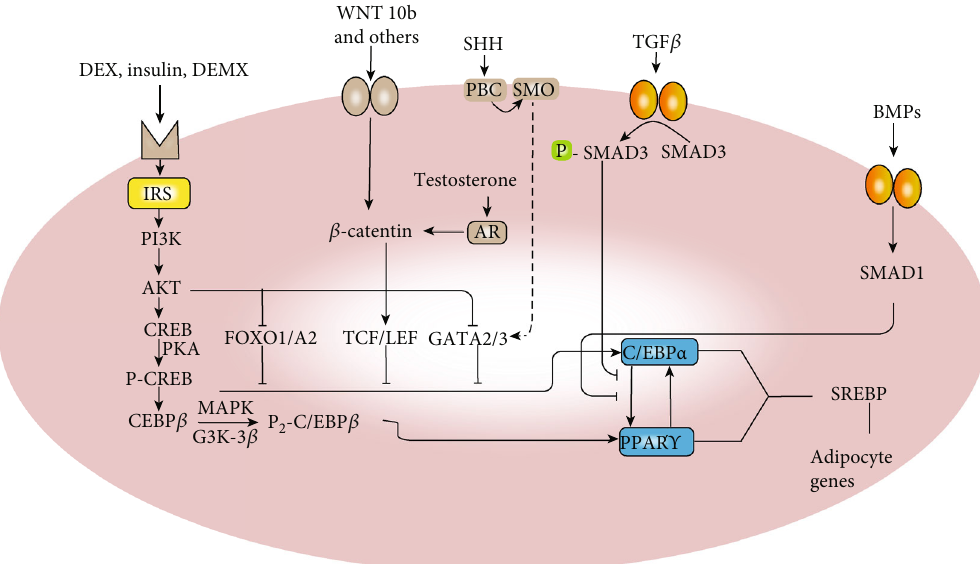
Figure 1: Regulation pathways in preadipocytes commitment. BMP and Wnt families are mediators of MSCs commitment to produce preadipocytes. Exposure of growth-arrested preadipocytes to di ff erentiation inducers (IGF1, glucocorticoid, and cAMP) triggers DNA replication, leading to adipocyte gene expression due to a transcription factor cascade. The dotted line indicates an uncertain molecular regulatory